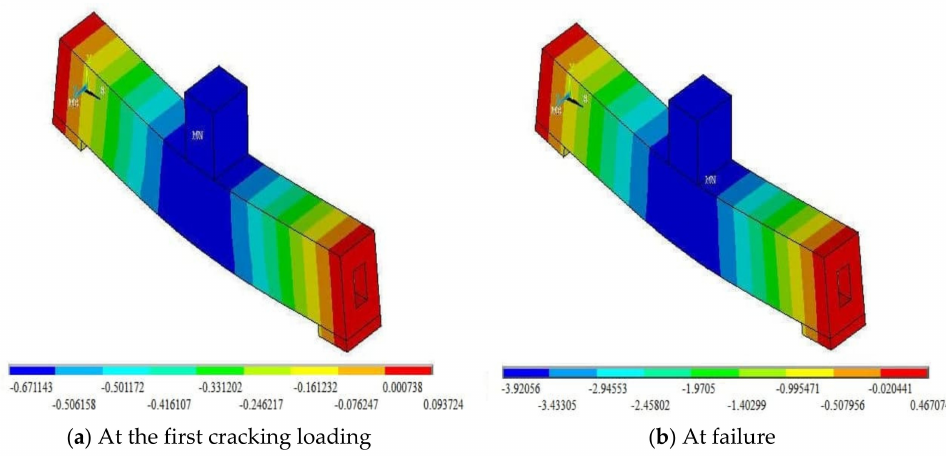
Figure 14. 3D deflection contours of beam model B6 at different loading